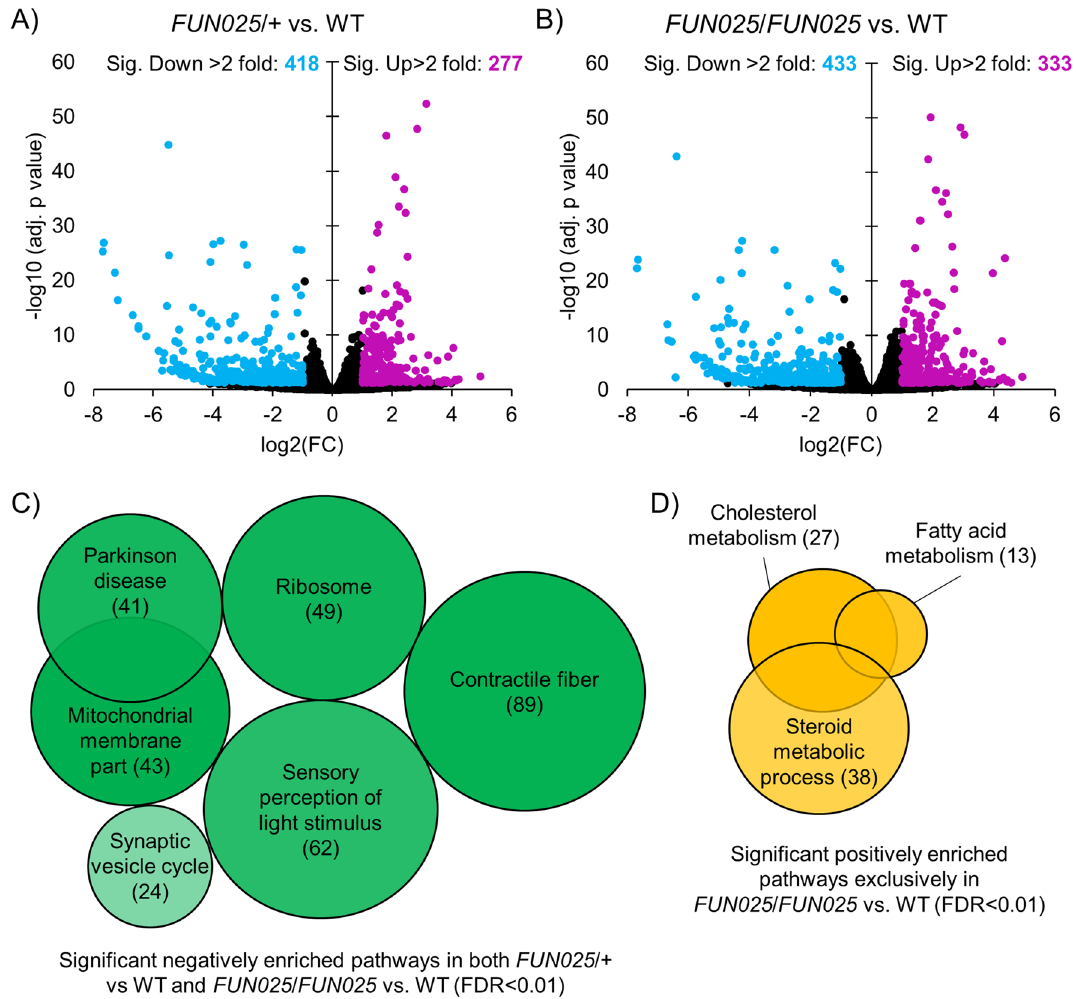
Figure 2. RNA-Seq analysis of 2.5-month-old heterozygous and homozygous Tmem135 mutant eyecups compared to WT eyecups. Volcano plot highlighting differentially-expressed genes with fold changes greater than 2 that reach statistical significance ( p < 0.05) between ( A ) Tmem135 FUN025 /+ ( FUN025/ + ) and WT eyecups as well as ( B ) Tmem135 FUN025/FUN025 ( FUN025/FUN025 ) and WT eyecups. Genes that are upregulated and downregulated are highlighted in magenta and cyan, respectively. Gene Set Enrichment Analysis (GSEA) results of significantly enriched gene sets (FDR < 0.01) of ( C ) downregulated genes and ( D ) upregulated in Tmem135 FUN025 /+ and Tmem135 FUN025/FUN025 eyecups compared to WT eyecups. The numbers within brackets indicate the number of genes in the leading edge in the gene set and the colour indicates the normalized enrichment score where the lighter tone means less enrichment and darker tone means more